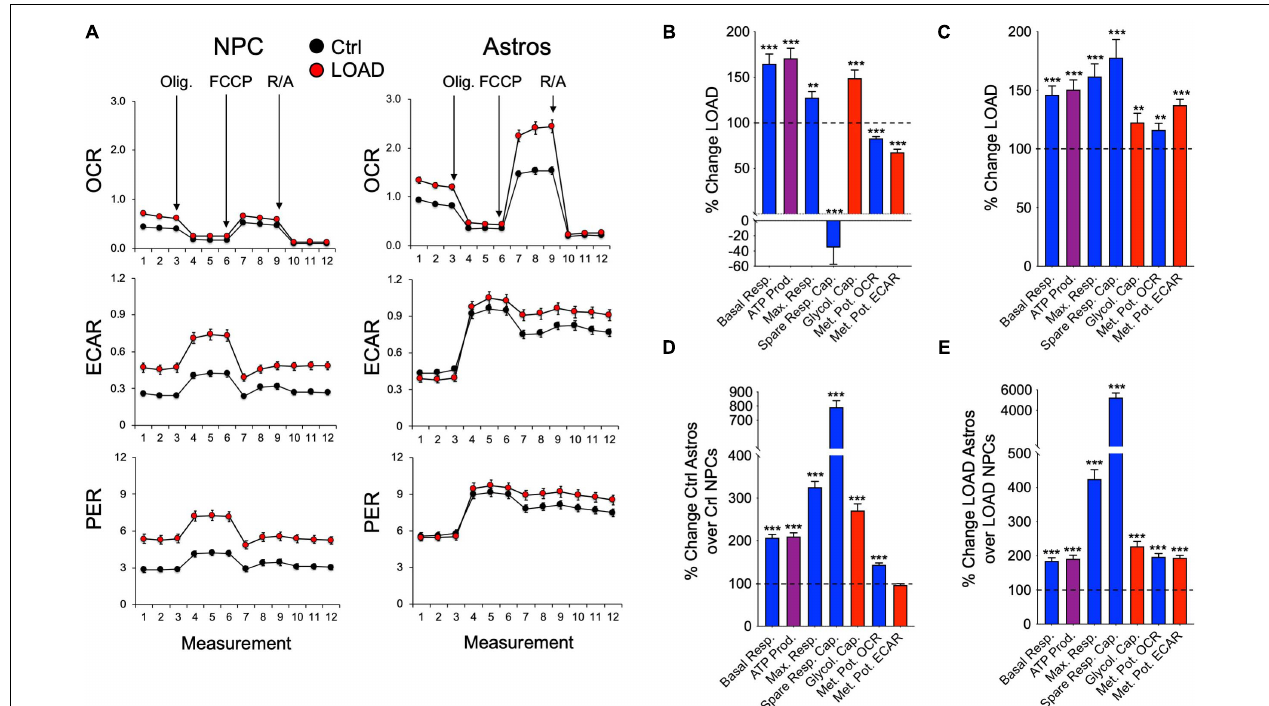
FIGURE 4 | Bioenergetic profiles of iPSC-derived NPCs and astrocytes. (A) Profiles of Seahorse XFp Mito Stress Test data for OCR (pmol/min), ECAR (mpH/min), and PER (pmol H + /min) in LOAD ( n = 9) and Control NPCs ( n = 9) and LOAD ( n = 9) and Control astrocytes ( n = 9). LOAD samples are in red and Control samples in black. Arrows indicate injections of oligomycin (Olig.), carbonyl cyanite-4 (trifluoromethoxy) phenylhydrazone (FCCP), and rotenone/antimycin A (R/A). (B–E) Calculated values of OCR (blue) and ECAR (red) parameters and results from Cell Energy Phenotype Test Report Generator for NPCs (B) and astrocytes (C) plotted as percent change LOAD over Control, and as change Ctrl astrocytes over Control NPCs (D) and LOAD astrocytes over LOAD NPCs (E) . Data are means +/- SEM from 2 to 4 repeat experiments. * p < 0.1; ** p < 0.05; *** p < 0.01 using one-way ANOVA.